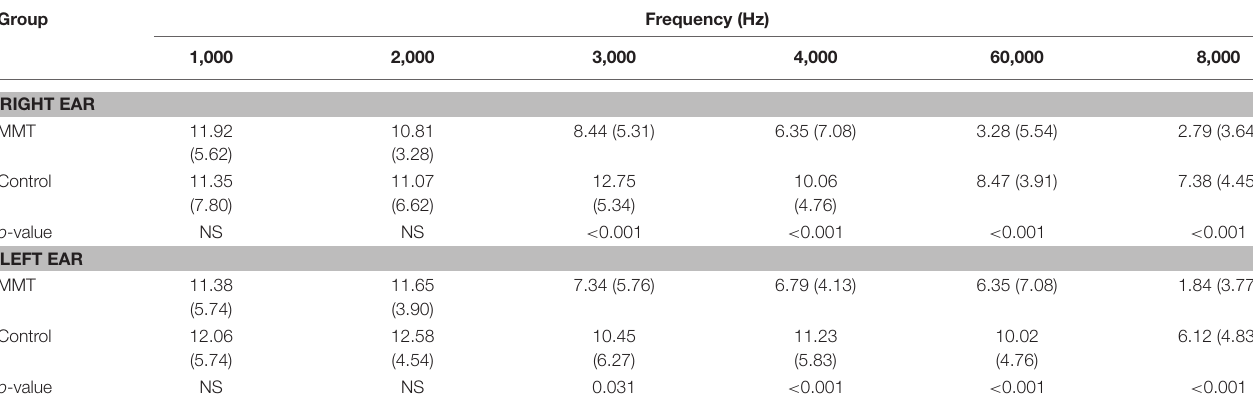
TABLE 2 | The DPOAE amplitudes in normal controls vs. patients underwent methadone maintenance treatment (MMT).